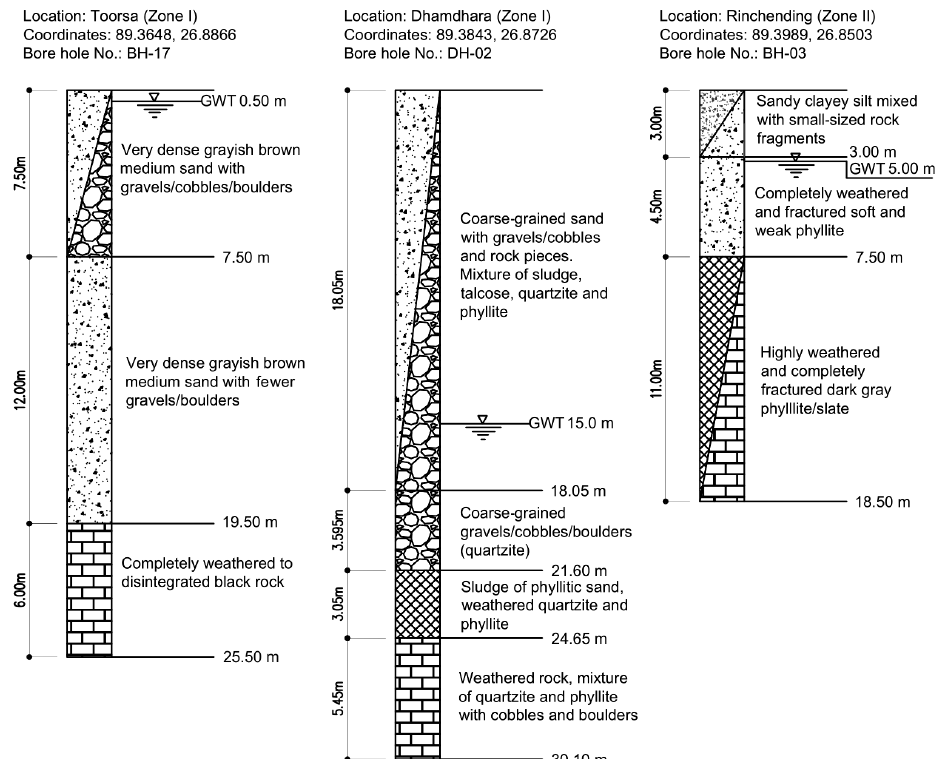
Figure 2. Typical borehole stratigraphy in Toorsa and Dhamdhara (Zone I) and Rinchending (Zone II).